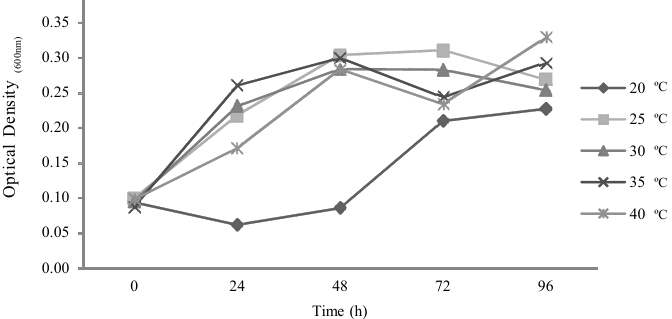
Fig. 5: Optical density of Rhodococcus pyridinivorans during the experiment under different